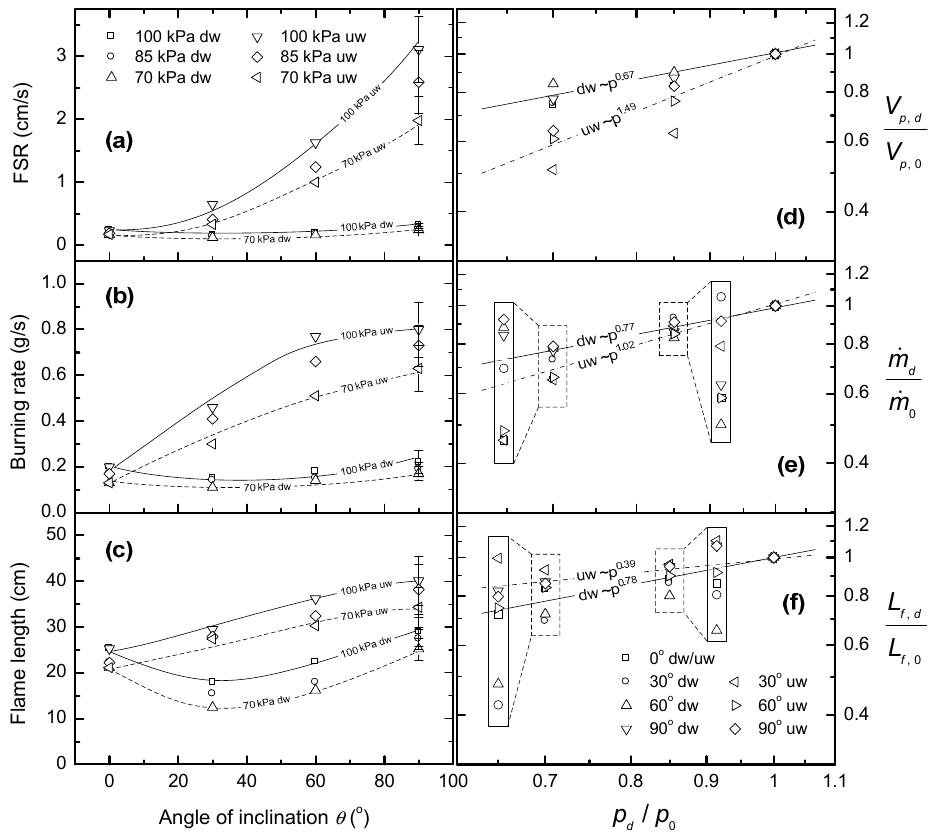
Figure 3. Burning characteristics and related normalization including flame spread rate (FSR) ( a , d ), burning rate ( b , e ) and flame length ( c , f ) for downward and upward flame spread, respectively, with various inclination under different pressures.